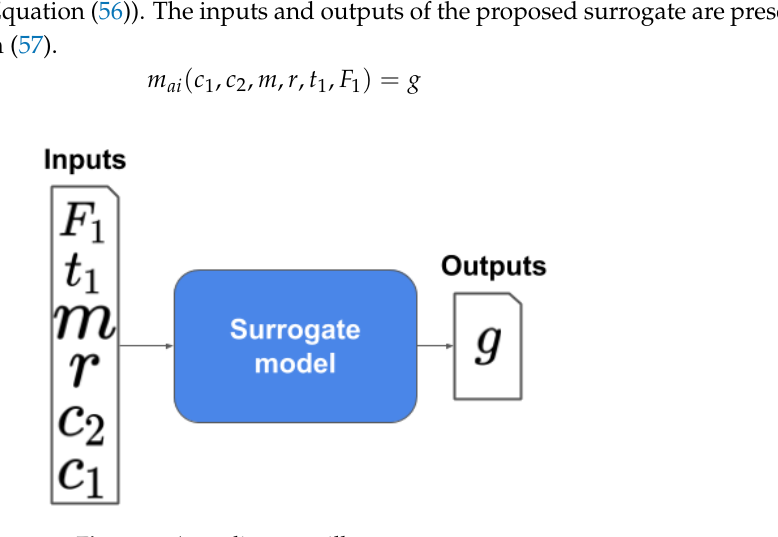
Figure 5. A nonlinear oscillator